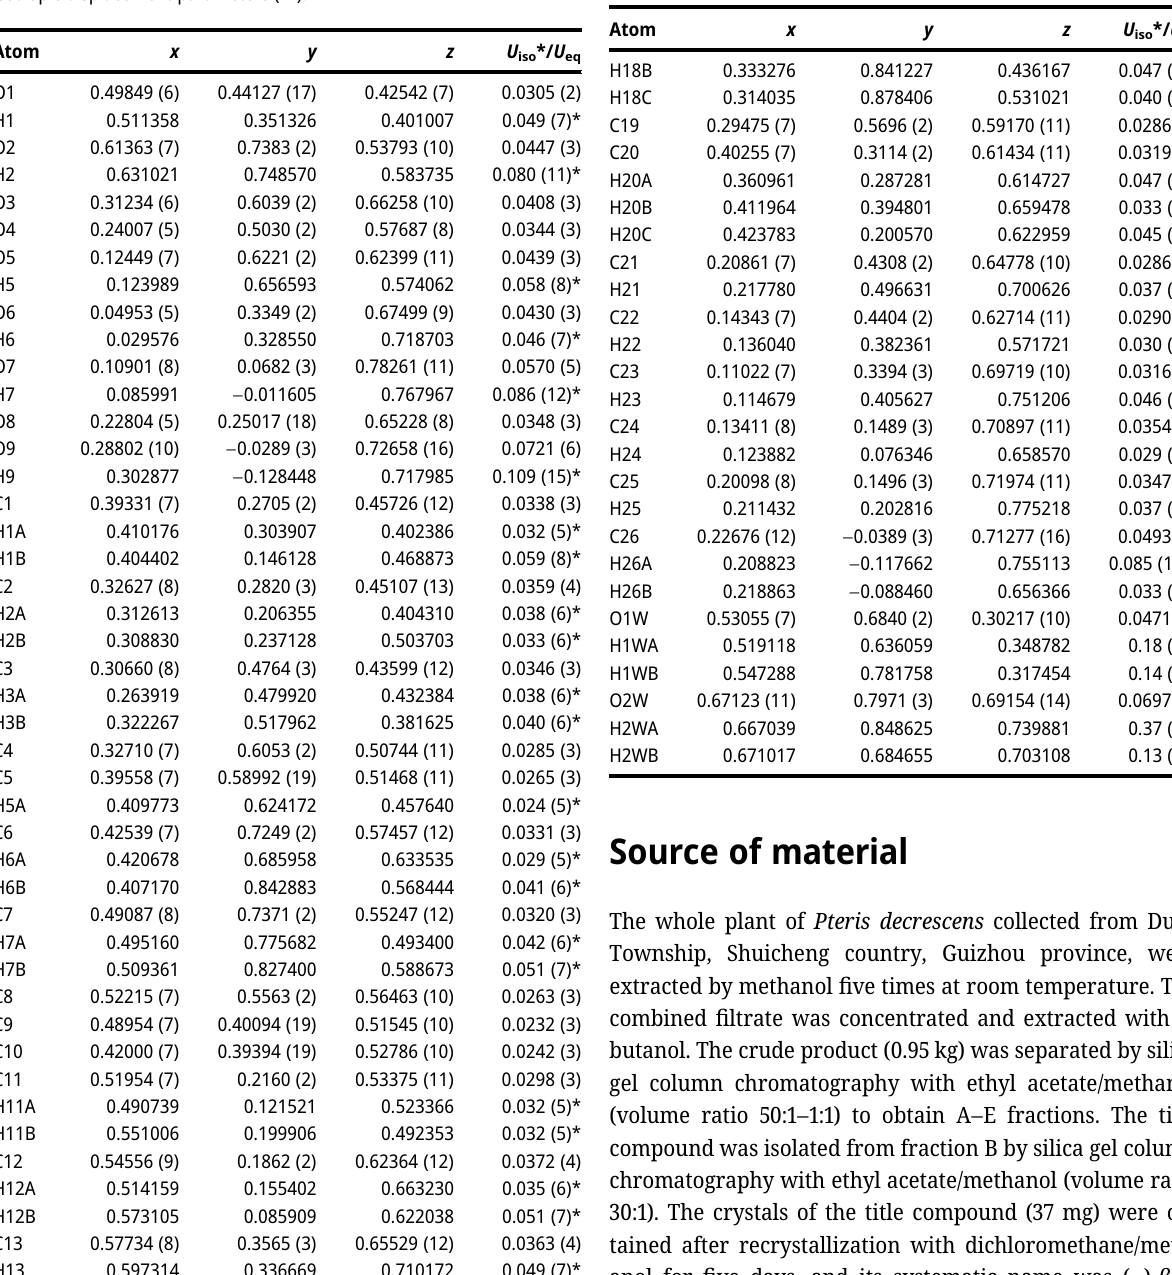
Table  : Fractional atomic coordinates and isotropic or equivalent isotropic displacement parameters (Å 